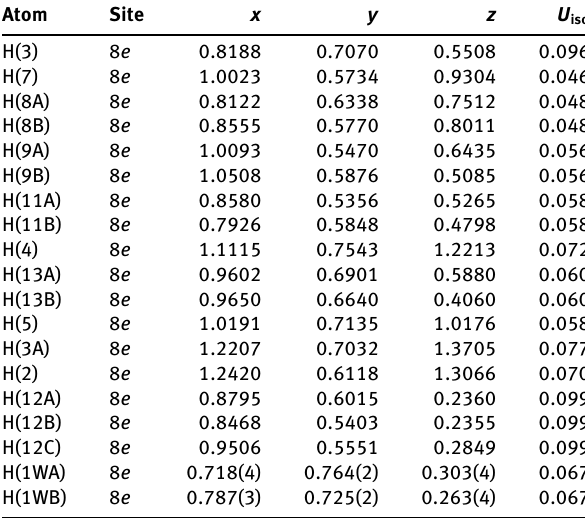
Table 2: Fractional atomic coordinates and isotropic or equivalent isotropic displacement parameters (Å 2